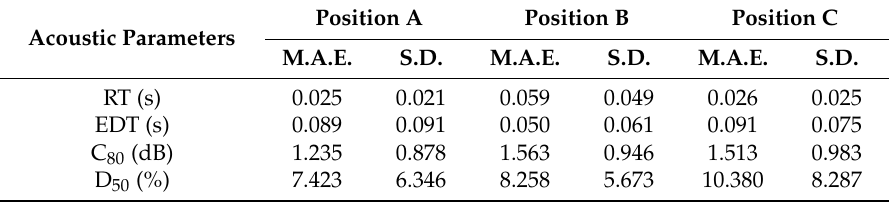
Table 2. Mean Absolute Error (M.A.E.) and Standard Deviation (S.D.) of RT, EDT, C 80 and D 50 for measurements with a directional speaker compared with measurements with the dodecahedral speaker for points A, B and C in the amphitheater.